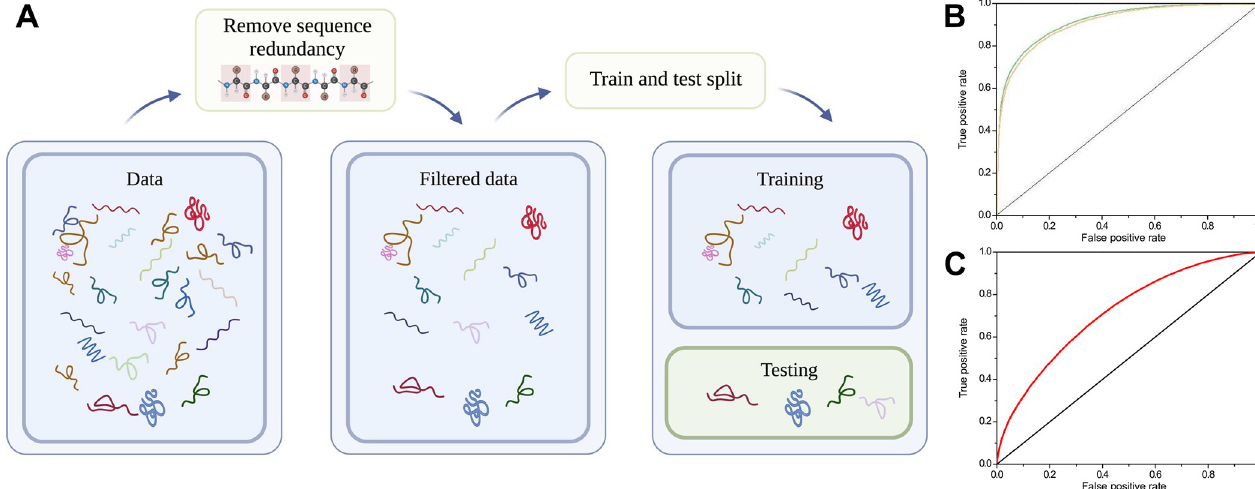
Fig 3. Filter on sequence redundancy. (A) Homologous proteins may end up in different datasets after the train and test split, sharing a large proportion of the amino acid sequence in this case makes the prediction task easy for the machine learning model (created with Biorender.com). (B) ROC plot without redundancy filtering for PPI interface prediction, yielding an unrealistically high AUC of 0.92. (C) In order to avoid this “data leakage” and to make sure that your model is tested and evaluated on data it has not seen yet, your datasets must be filtered on sequence identity before training and testing the model, here yielding an AUC of 0.72. Based on data from Hou and colleagues